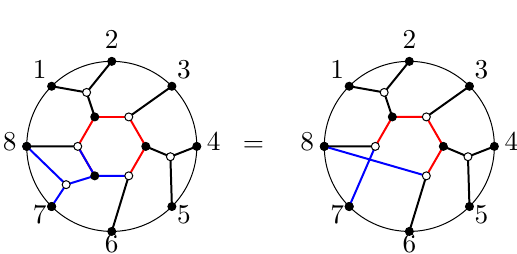
Figure 4. An example of arborization, where we break the inner hexagon on the left by applying the first and seventh skein relations shown in figure 5 to the blue edges. (The blue and red colorings serve only to guide the